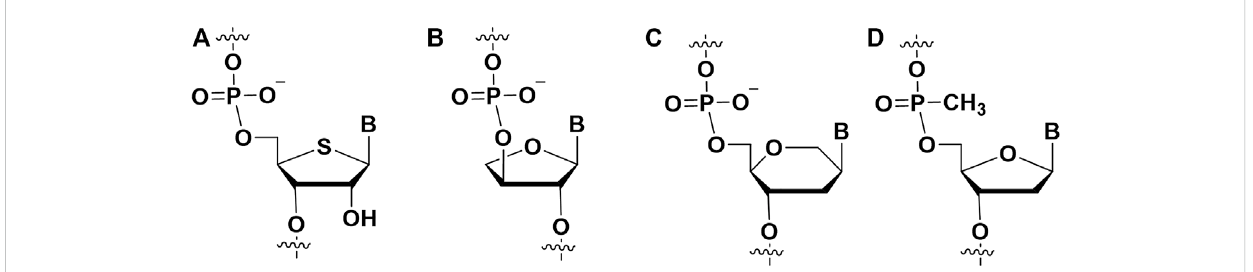
FIGURE 4 The ribose modi fi cations on the aptamers to enhance binding af fi nity. (A) 4 ′ -S modi fi cation; (B) TNA modi fi cation; (C) HNA modi fi cation; (D) phNA modi fi cation.